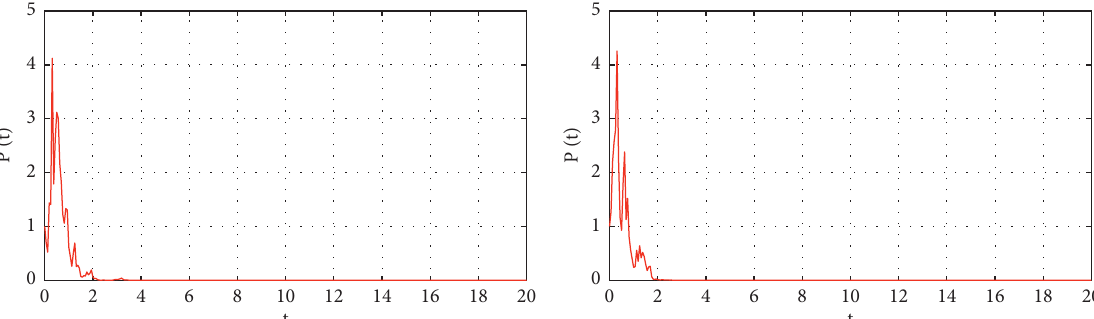
Figure 4: The trajectories of system (91) with P � 1 ,H � 0 . 5. (a) θ � 1 ,u � 2 ,v � 1. (b) θ � 1 , u � 1 ,v � 2. The trajectories of system (91) 0 are almost surely exponentially stable for both (a) and (b) in the sense of Theorem 5 (ii).